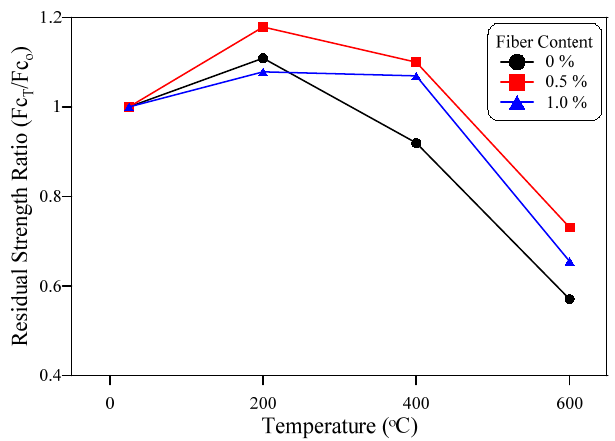
Figure 9. Residual compressive strength after high-temperature exposure.